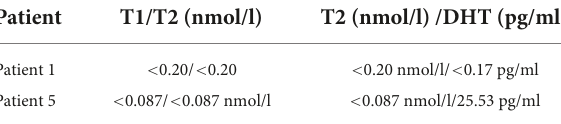
TABLE 2 Human chorionic gonadotrophin stimulation result of the